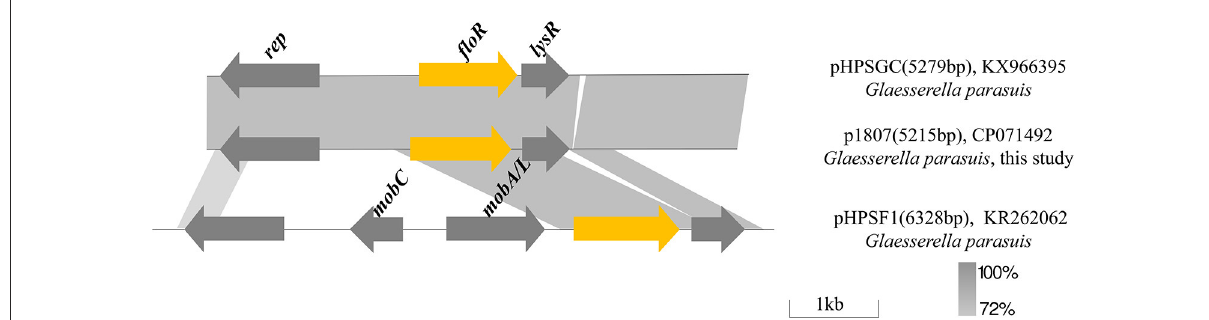
FIGURE6 Comparison of plasmids p1807 (CP071492), pHPSGC (KX966395), and pHPSF1 (KR262062). Arrows indicate gene positions and transcriptional orientation. Regions of > 72% homology are marked by gray